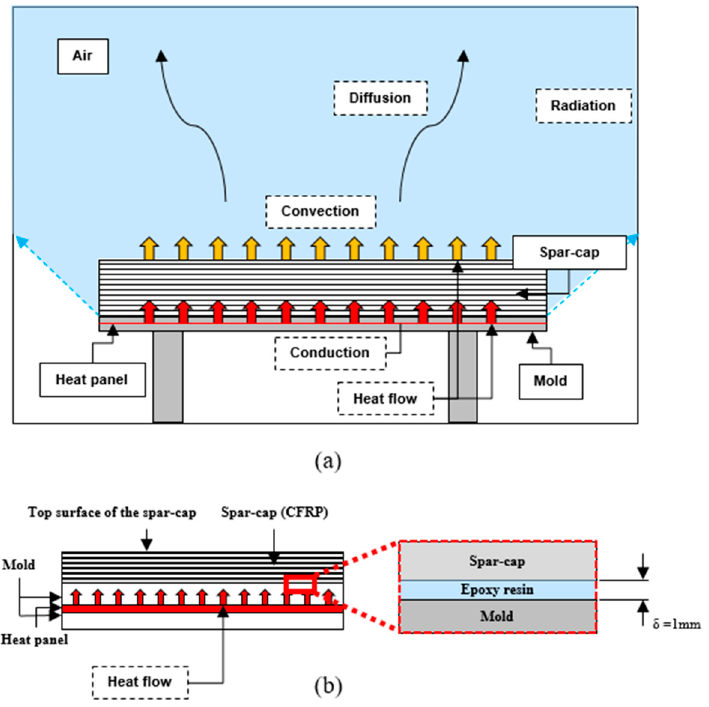
Figure 4. Cross-sectional view of boundary conditions for heat transfer simulation: ( a ) spar-cap manufacturing process; ( b ) contact heat conduction of the interface between spar-cap and mold. Table 1. Thermophysical properties of materials constituting CFRP.